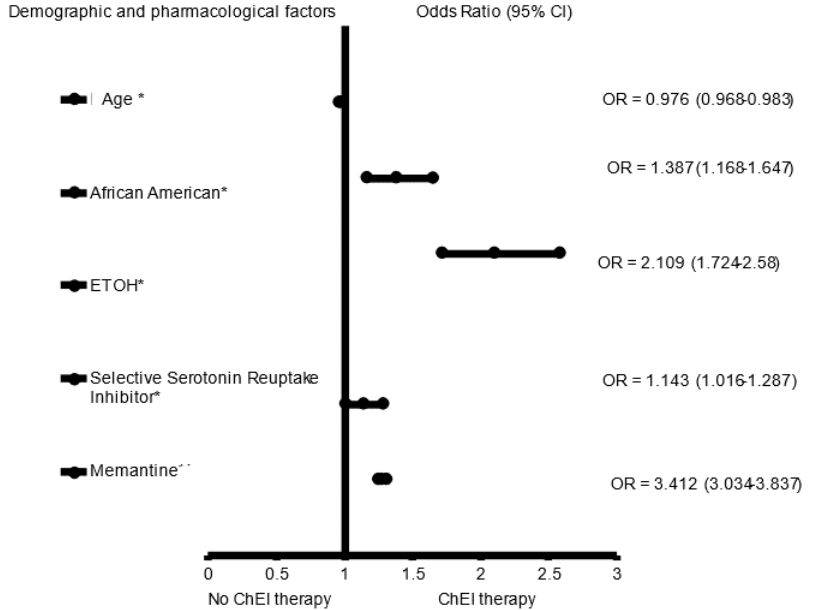
Figure 5. The forest plot for the demographics and pharmacological characteristics associated with cholinesterase inhibitor (ChEI) for the women late onset Alzheimer’s disease patient population. Adjusted OR < 1 denote factors that are associated with not receiving ChEI while OR > 1 denote factors that are associated with receiving ChEI. Hosmer_Lemeshow test ( p < 0.001 *), Cox and Snell ( R 2 = 0.103). The overall classified percentage of 66.6% was applied to check for fitness of the logistic regression model. * Indicates statistical significance ( p < 0.05) with a 95% confidence interval.